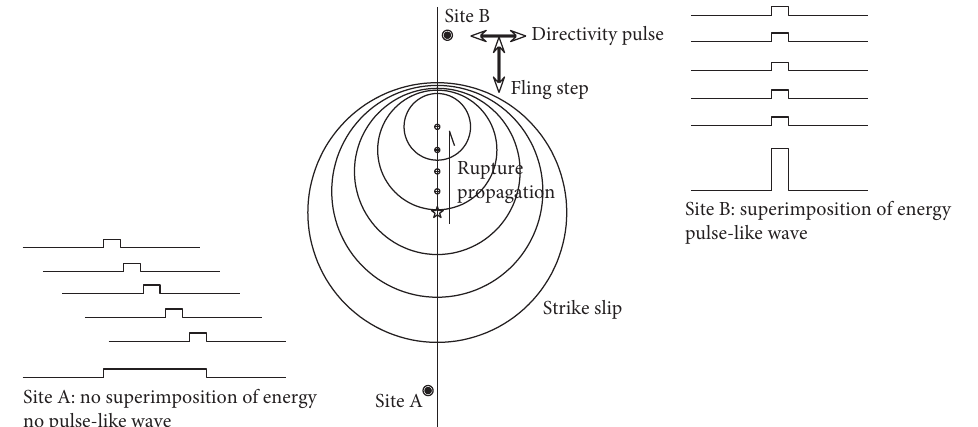
Figure 1: Schematic of causes of fling step and directivity pulse